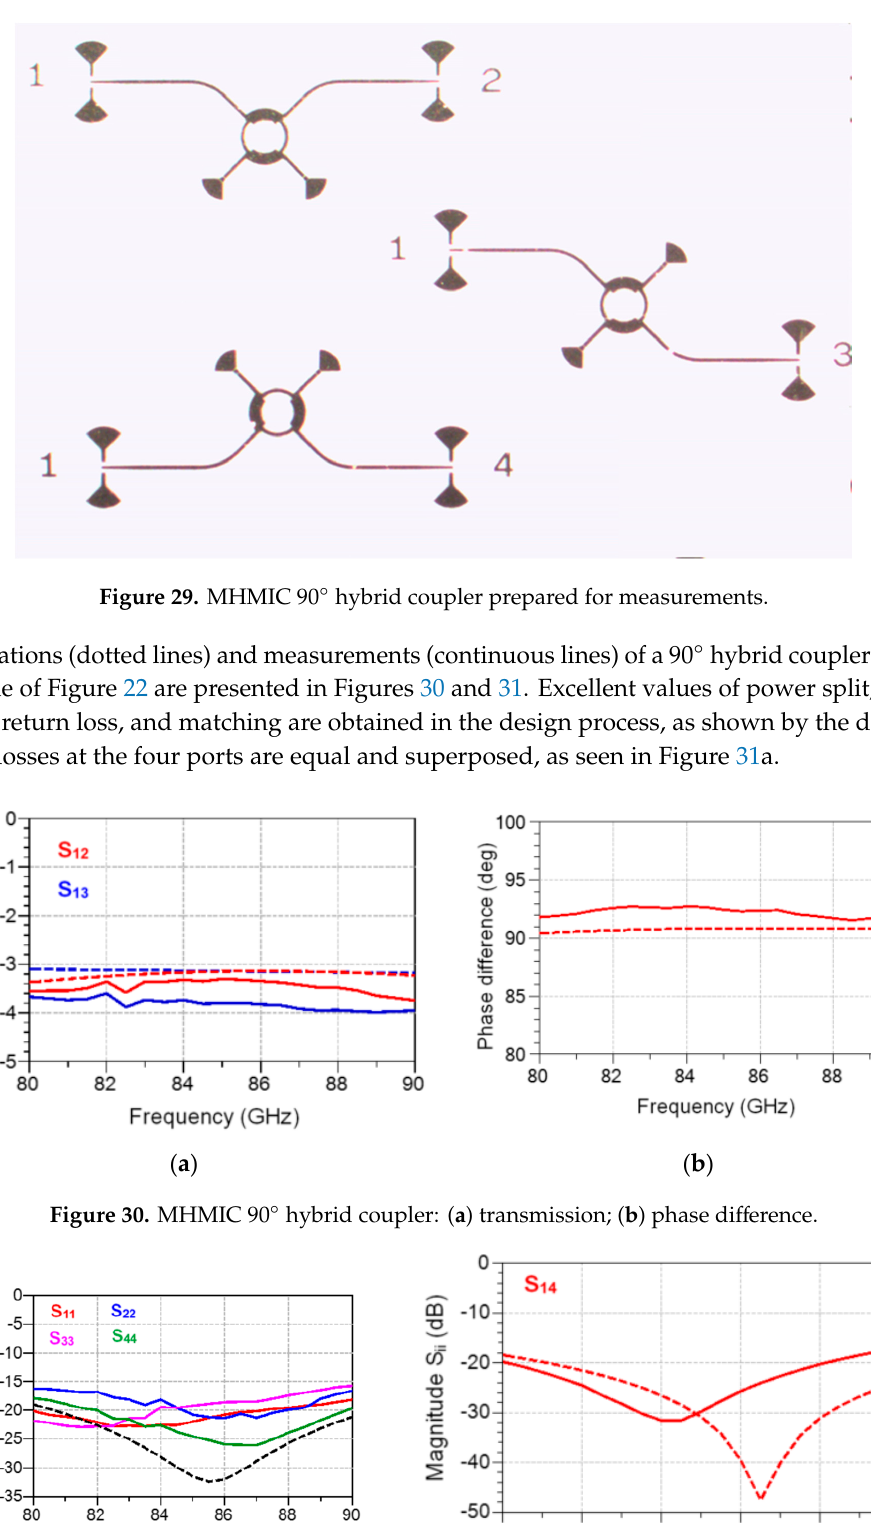
Figure 31. MHMIC 90° hybrid coupler: ( a ) matching; ( b ) isolation. Figure 31. MHMIC 90 ◦ hybrid coupler: ( a ) matching; ( b )